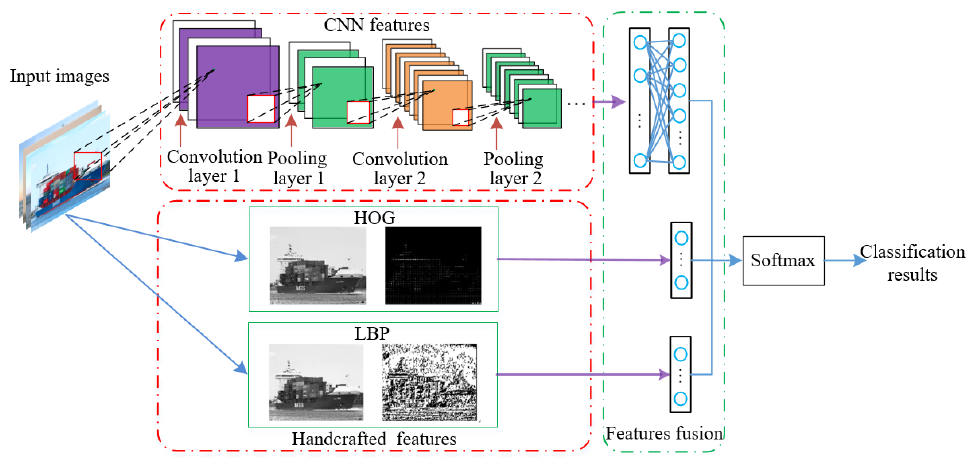
Figure 2. The flowchart of the proposed ship classification framework.